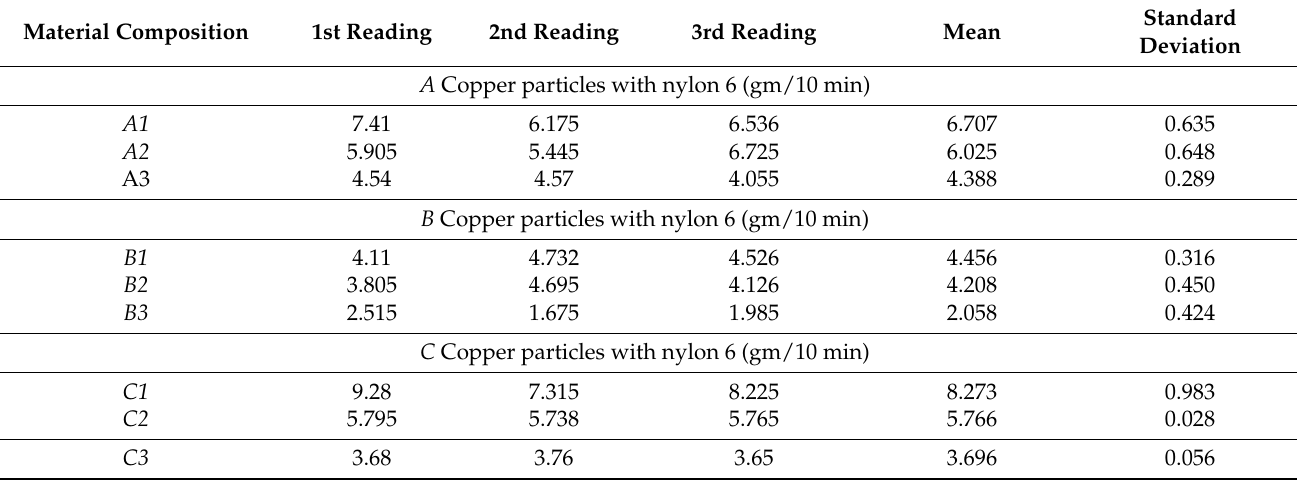
Table 3. MFI of nylon 6 reinforced with copper